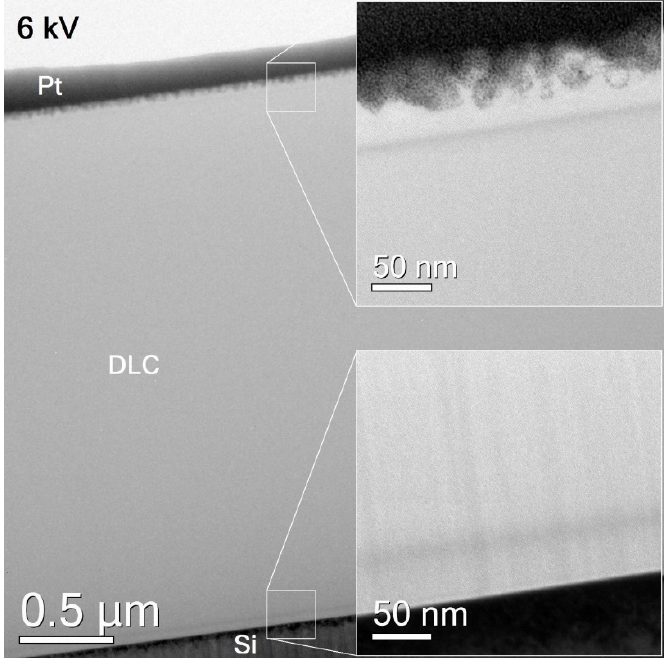
Figure 5. Cross-sectional TEM image of a DLC coating on silicon produced with an acceleration voltage of 6 kV. Insets show magnified regions at the